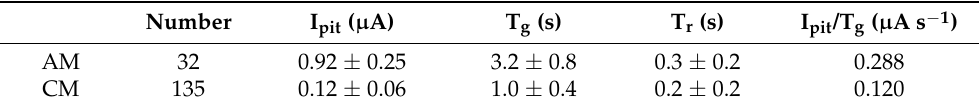
Table 2. Average values (5 tests) obtained for the different parameters that are characteristic of the metastable pits for both the AM and CM samples of